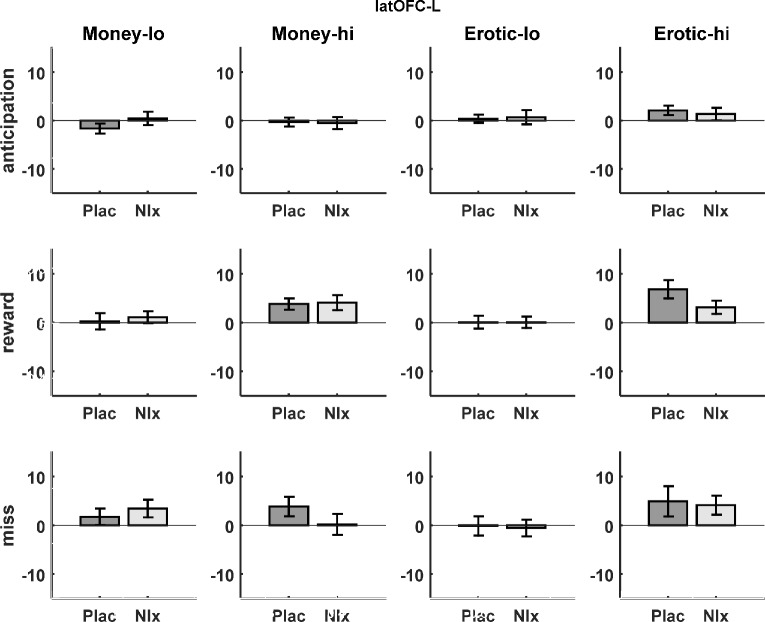
Left lateral orbitofrontal cortex fMRI responses (arbitrary units) for all stimuli (money/erotic, high/low) and time-points (anticipation, outcome: reward, outcome: miss) under placebo (Plac) and naloxone (Nlx).Error bars represent standard error of the mean.